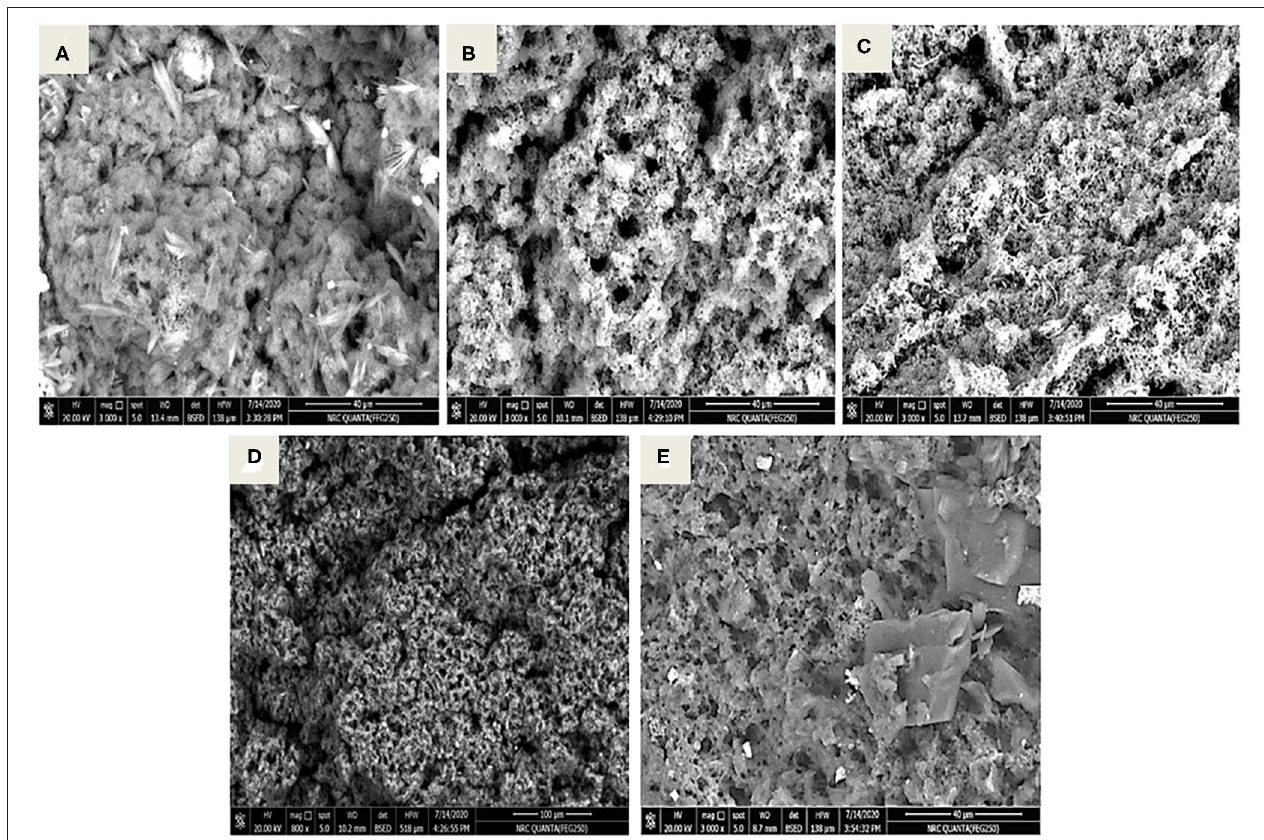
FIGURE 5 | Micrographs of stirred functional yogurt products (X500, 50 µ m, 10 kV). (A) Control plain SFY. (B) SFY fortified with free Fe + ascorbic acid (T 1 ). (C) SFY fortified with free Fe + FA + ascorbic acid (T 2 ). (D) SFY fortified with Fe@ BSA-NPs + ascorbic acid (T 3 ). (E) SFY fortified with Fe + FA @ BSA-NPs + ascorbic acid (T 4 ). BSA-NPs, Bovine Serum Albumin nanoparticles; FA, Folic